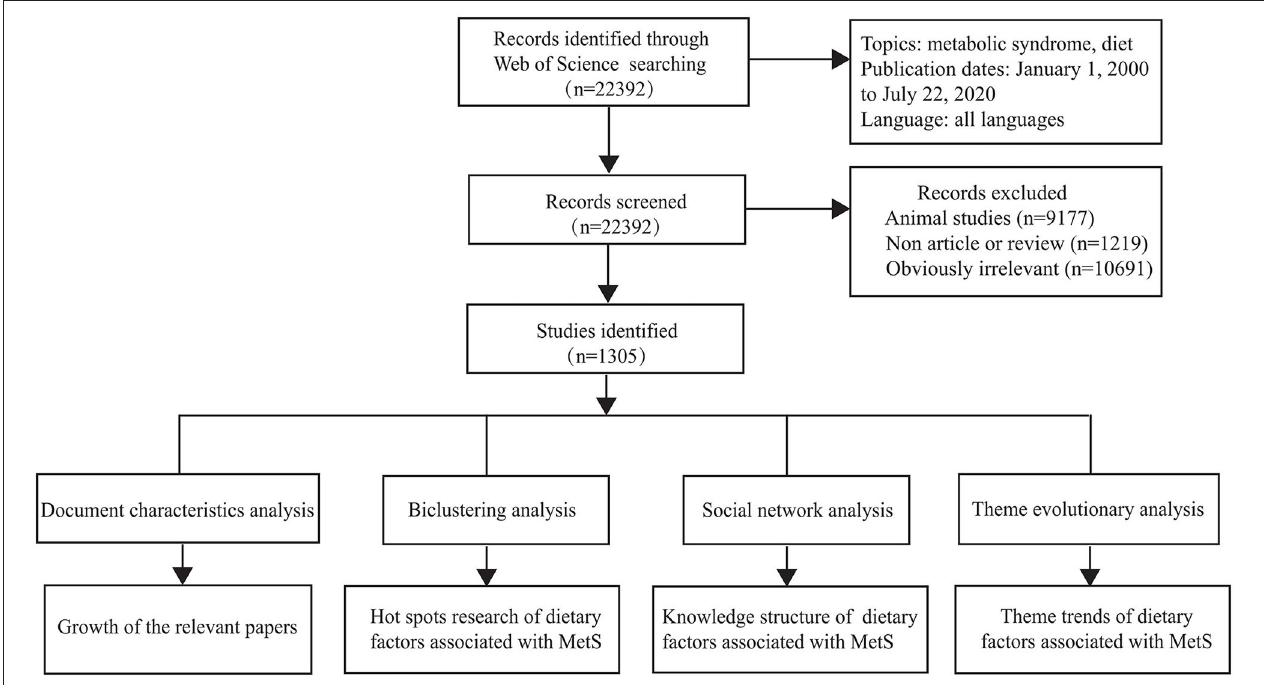
FIGURE 1 | The detailed process of literature retrieval, study selection, and bibliometric analysis.